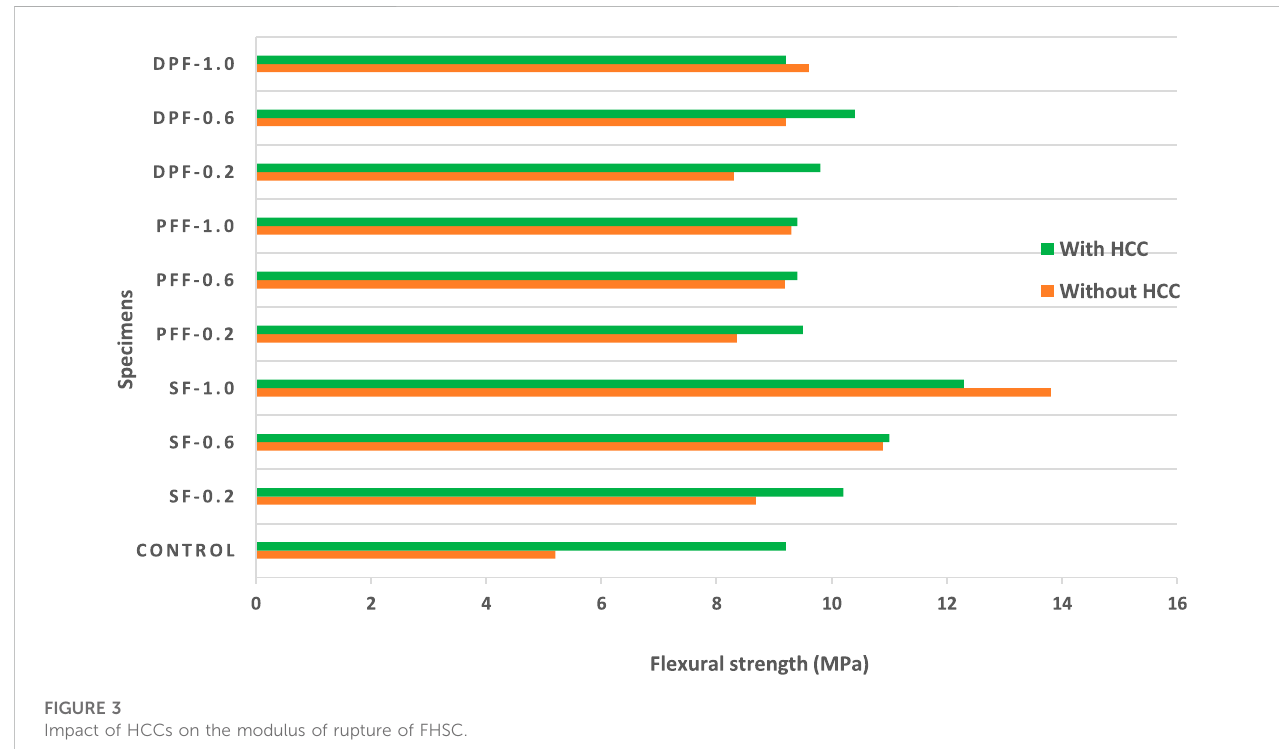
FIGURE 3 Impact of HCCs on the modulus of rupture of